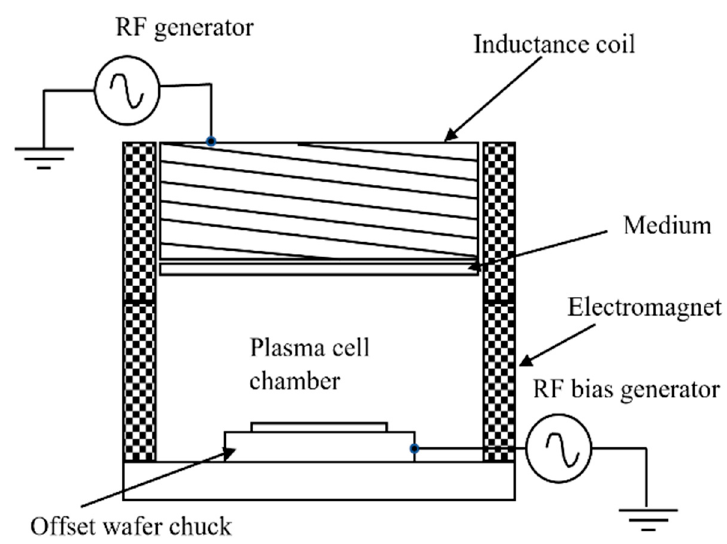
Figure 6. Schematic diagram of inductively coupled plasma.